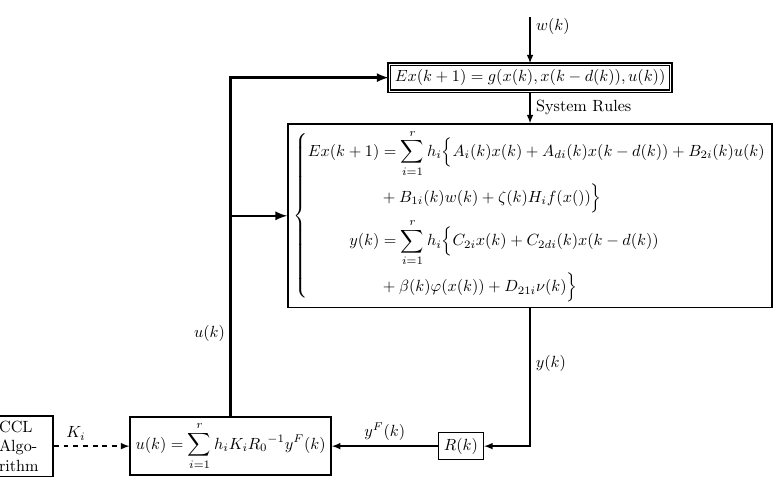
Figure 1. Flowchart of the control procedure.